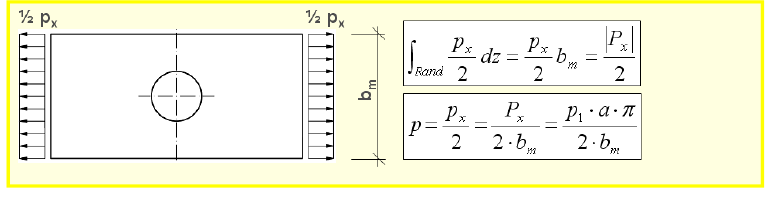
Figure 6: Basic stress state